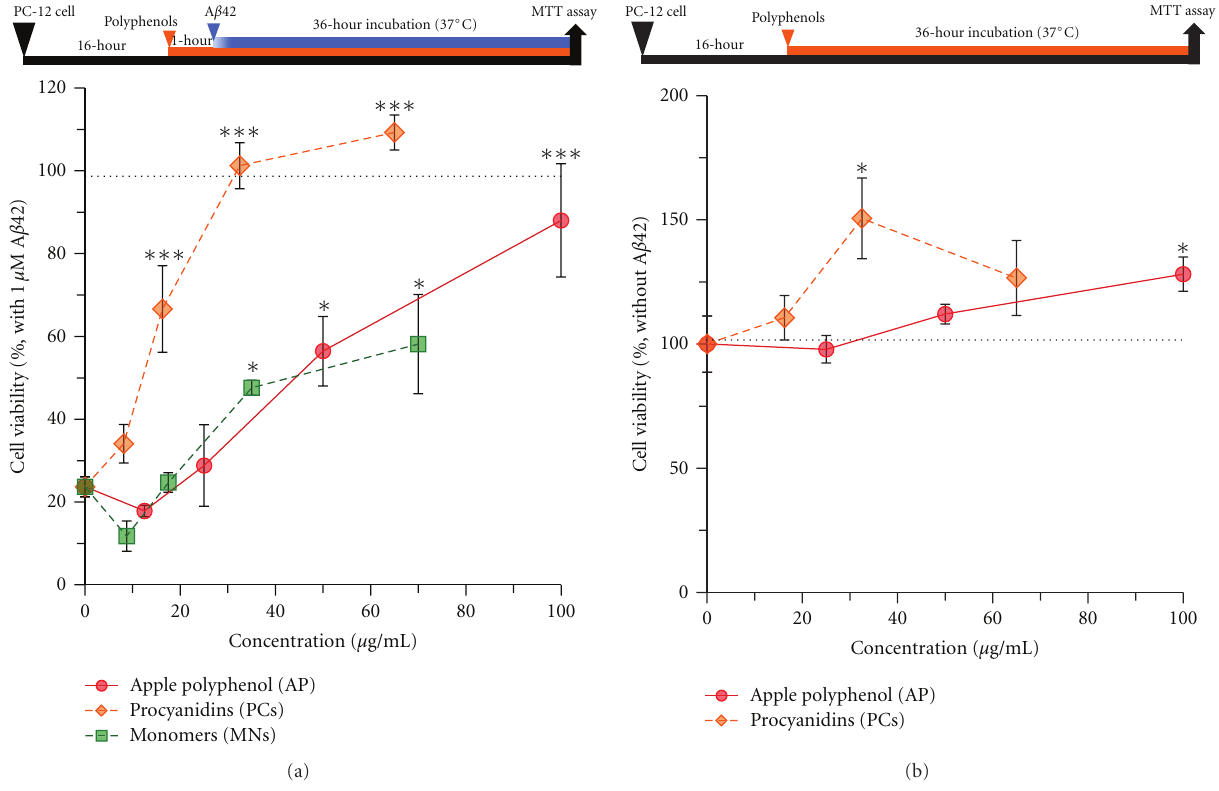
Figure 4: Procyanidins restore viability of PC-12 cells treated with A β 42. Cells were pretreated with various concentrations of AP, PC and MN for 1 hour, and then, incubated with (a) or without (b) 1 μ M A β 42 for 36 hours. Cell viability was measured by the MTT assay. Values are the means ± s.e.m., n = 3. (Compared to the control group (0 μ g/mL), ∗∗∗ P < 0 . 001 and ∗ P < 0 . 05 (Dunnett’s